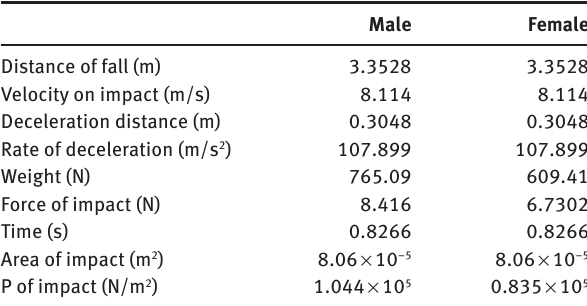
Table 3: Correlation rate of fall and impact on the forearm, elbow and wrist